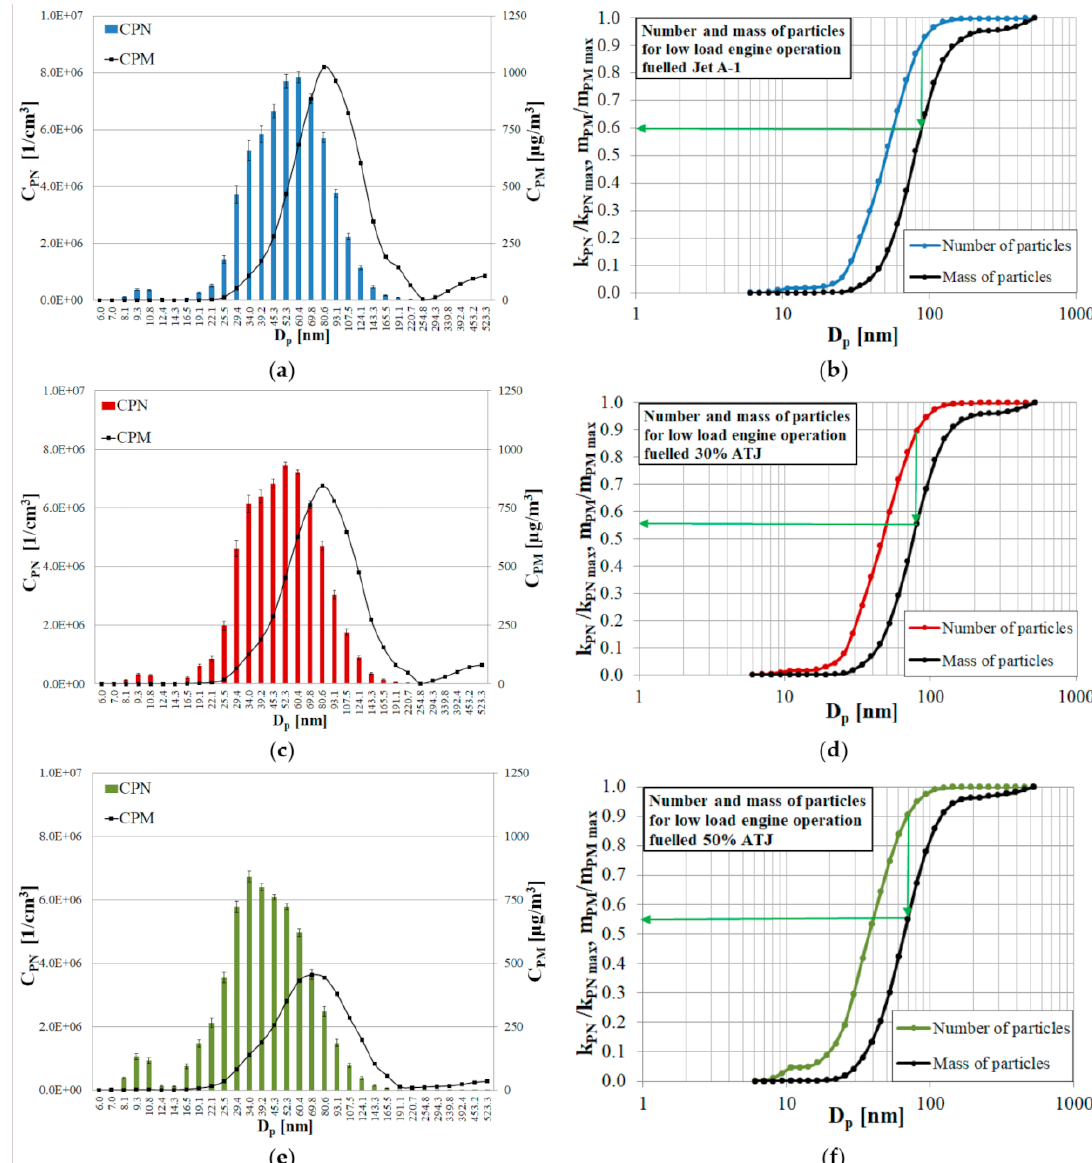
Figure 5. Number and mass concentration of particles depending on their diameter ( a , c , e ) and cumulative values of the relative particles number and relative mass of particulate matter ( b , d , f ) for low engine operation load fueled Jet A-1 ( a , b ), 30% ATJ ( c , d ) and 50% ATJ ( e , f